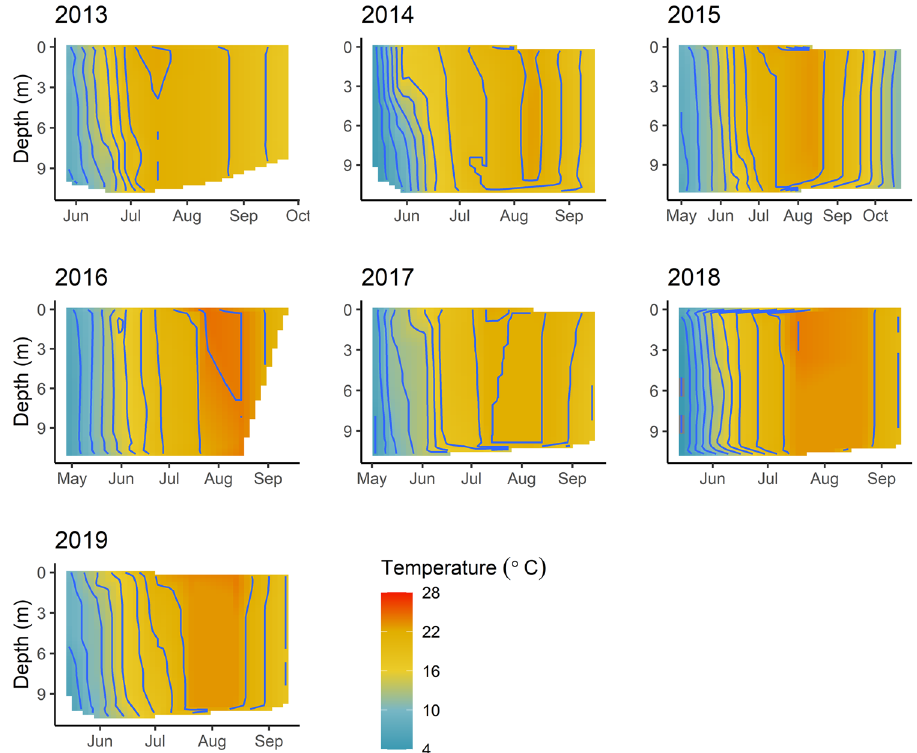
Fig. 2 Temperature (°C) heat maps from May-September/October of 2013-2019 from Lake Mille Lacs. The heat maps were produced by extrapolating temperature pro fi le data between sampling dates. We excluded years prior to 2013 due to incomplete